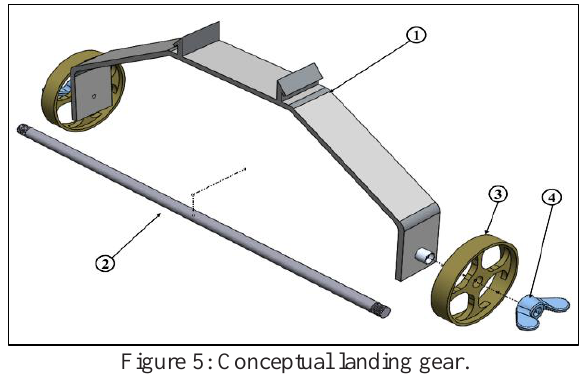
Figure 5: Conceptual landing